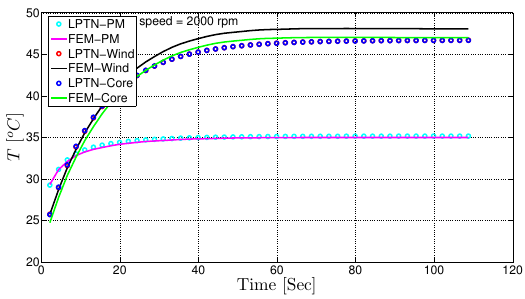
Figure 15. Machine temperature at speed = 2000